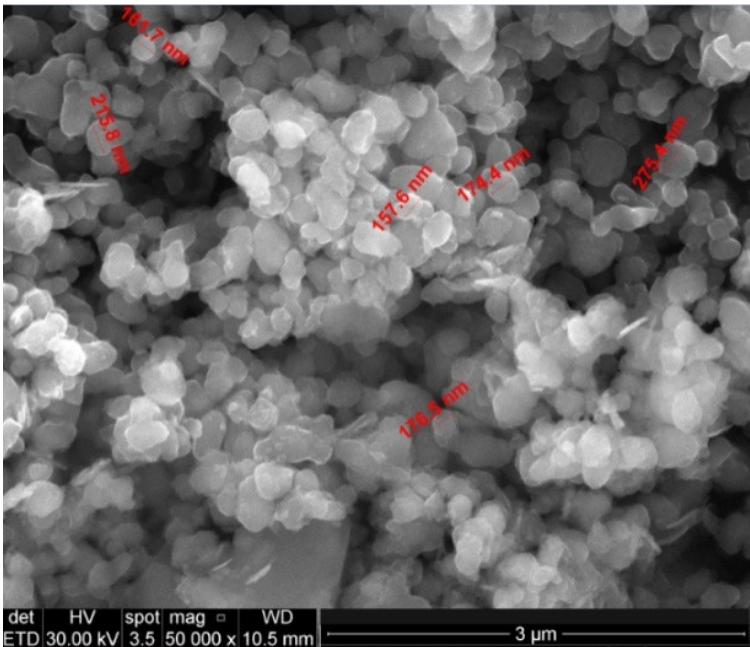
on TiO 2 ), and S2 (sample with 10% Ca and 2% Cu on TiO 2 ). The morphology of the ob- tained samples was evidenced by scanning electron microscopy (SEM) (Figure 1).